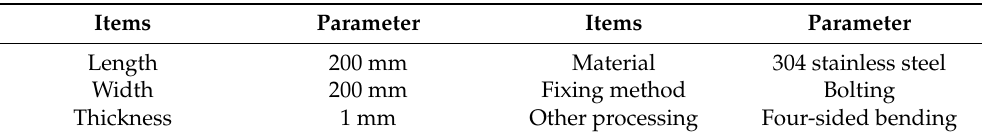
Table 2. Important parameters of impact plate.